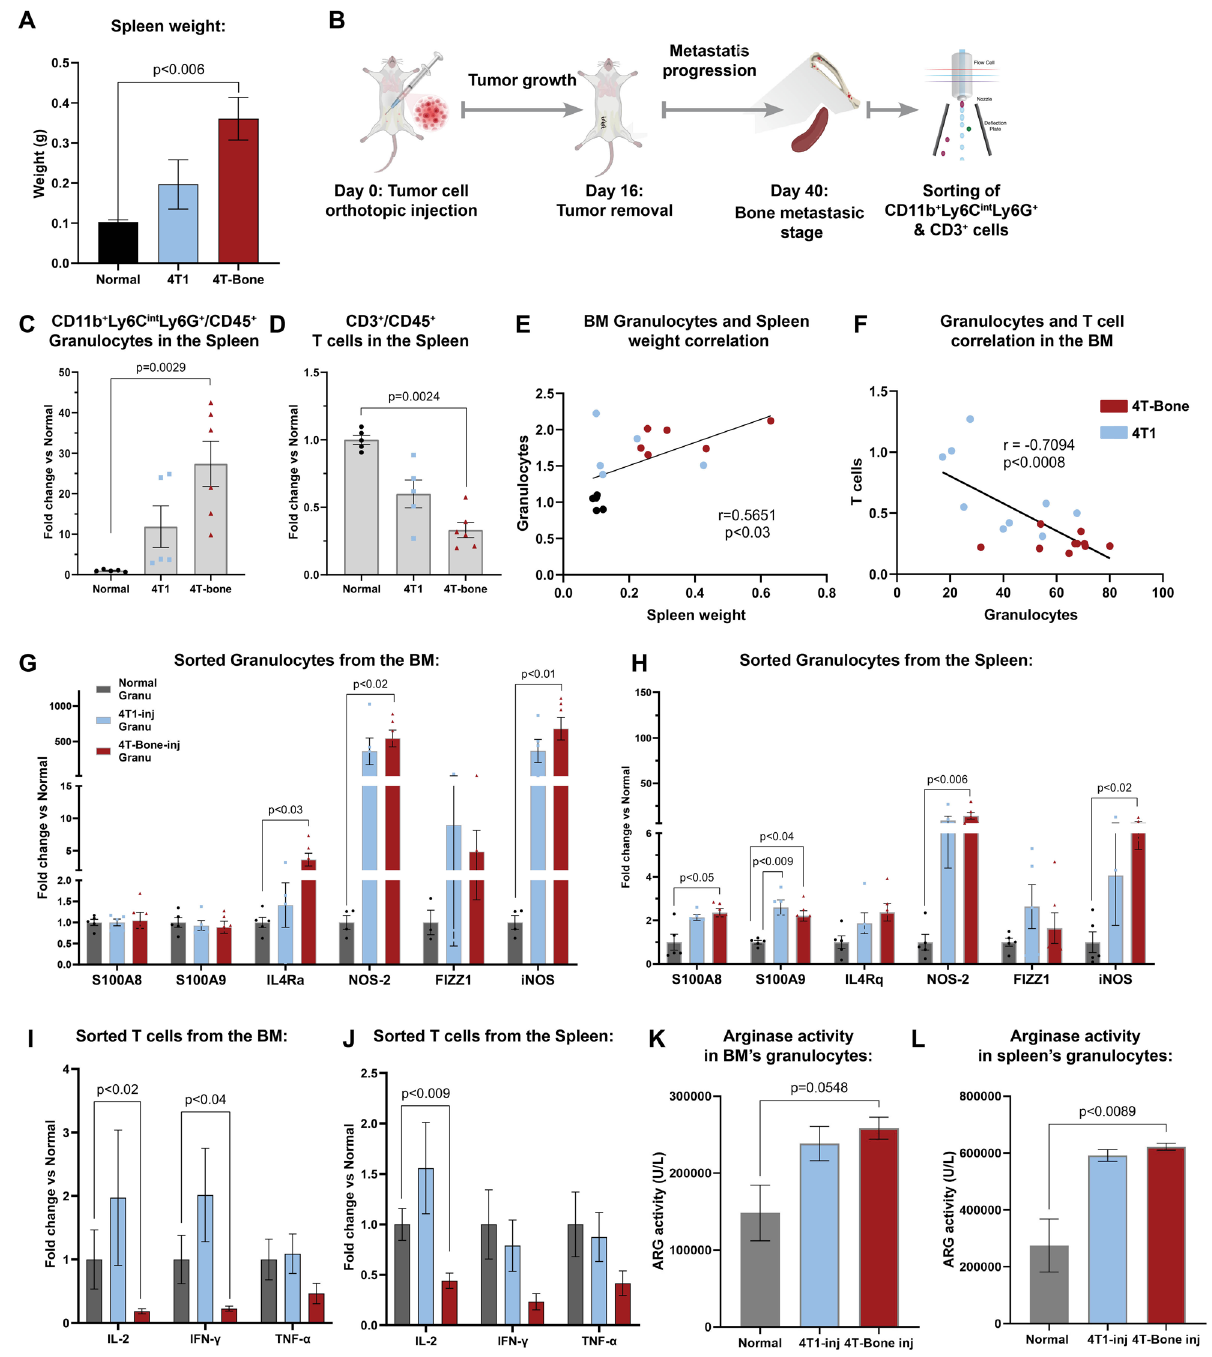
Figure 3. Granulocytes and T cells in BM and spleen comprise an immunosuppressive phenotype. ( A ) Spleen weight at day 40. Error bars represent SEM of biological repeats. n = 5–6. ( B ) Scheme of experimental design. Granulocytes (CD45 + CD11b + Ly6C int Ly6G + ) and T cells (CD45 + CD3 + ) were analyzed and isolated. This scheme was designed by using graphical elements from BioRender. ( C , D ) Quantification of granulocytes and T cell population in the spleen of normal, 4T1-injected or 4T-Bone-injected mice. Error bars represent SEM of biological repeats. One way ANOVA was performed. n = 5–6. ( E ) Correlation between spleen weight and the abundance of granulocytes in the BM of 4T1 (n = 9) and 4T-Bone (n = 10) injected mice. ( F ) Correlation between Granulocytes and T cells in the BM of 4T1 (n = 9) and 4T-Bone (n = 10) injected mice. ( E , F ) Pearson correlation was performed. ( G ) qPCR analysis of the expression of immunosuppressive signature expressed by granulocytes isolated from the BM ( G ) and the spleen ( H ) of normal/4T1/4T-Bone-injected mice at day 40. ( G , H ) Error bars represent SEM of biological repeats. One-way ANOVA was performed. n = 5. ( I ) qPCR analysis of the expression of activation markers in T cells isolated from the BM ( I ) and the spleen ( J ) of normal/4T1/4T-Bone-injected mice at day 40. ( I , J ) Mann–Whitney test was perfomed. Error bars represent SEM of biological repeats. n = 5. ( K , L ) Arginase activity in sorted granulocytes from the BM ( K ) and spleen ( L ), One-way ANOVA was performed. Error bars represent SEM of biological repeats. n =